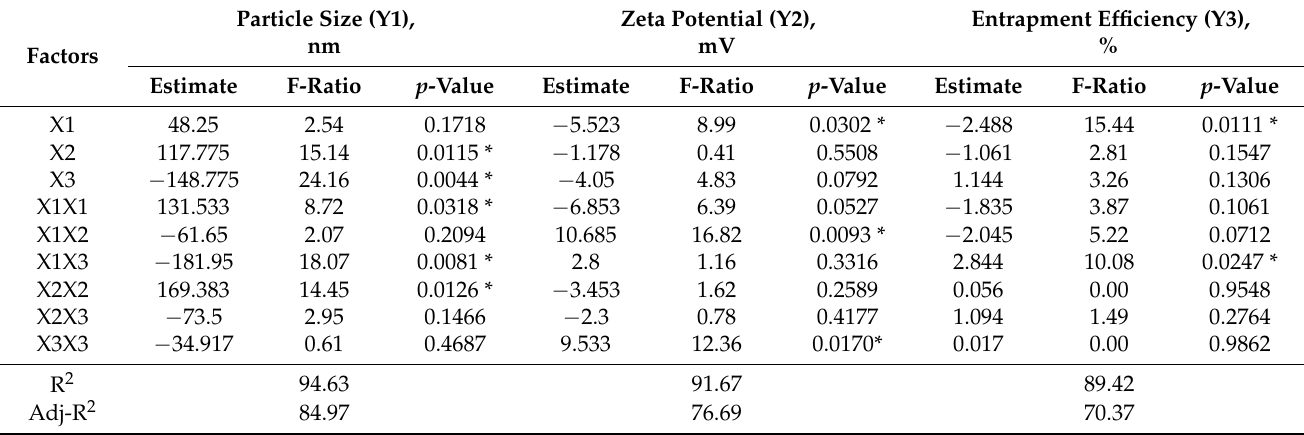
Table 3. Statistical analysis with the estimated effects of factors, F-ratio, and associated p -values for the prepared FLZ-loaded